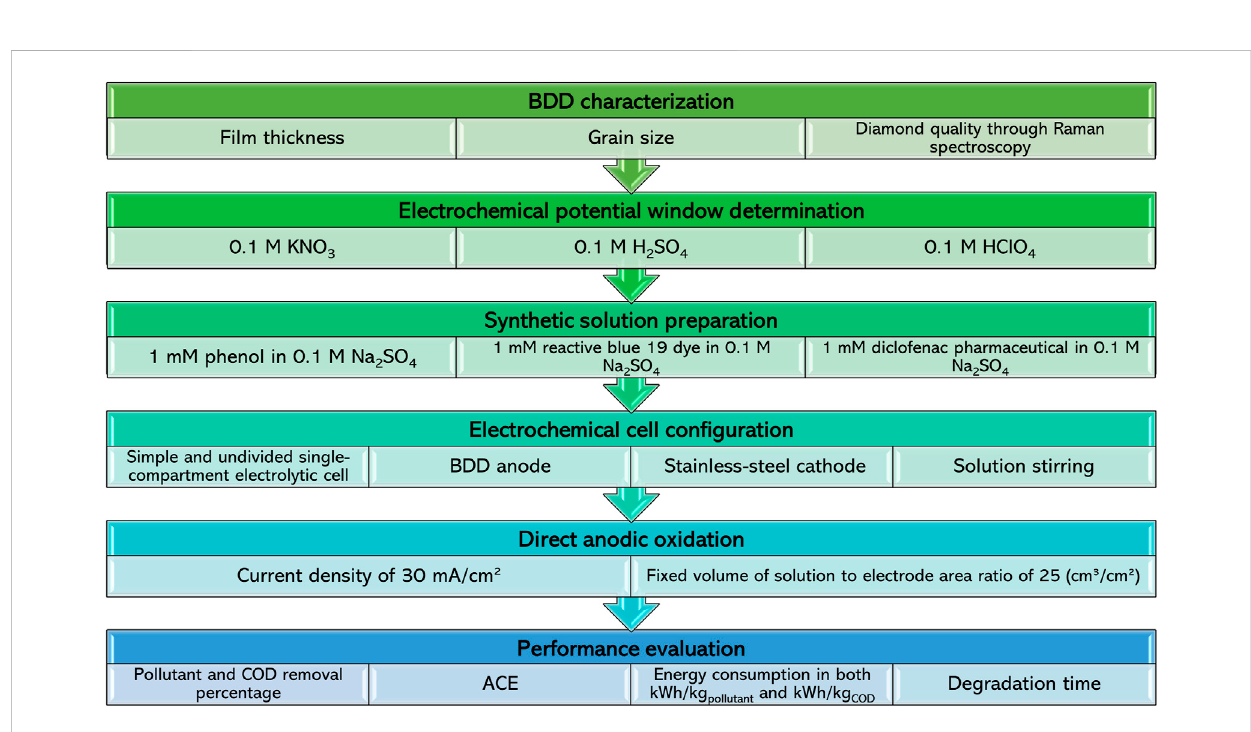
FIGURE 9 Experimental procedure proposed for evaluating BDD electrodes (source: the